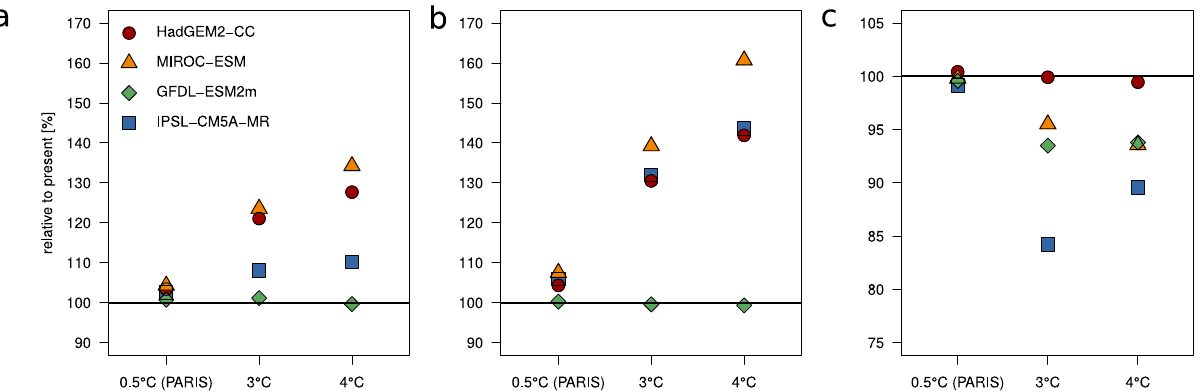
Fig. 3 Storylines of area-mean rainfall and soil moisture changes. a Maximum 5-day rainfall, b maximum 3-h rainfall, c 2m-integrated soil moisture for different model simulations and warming